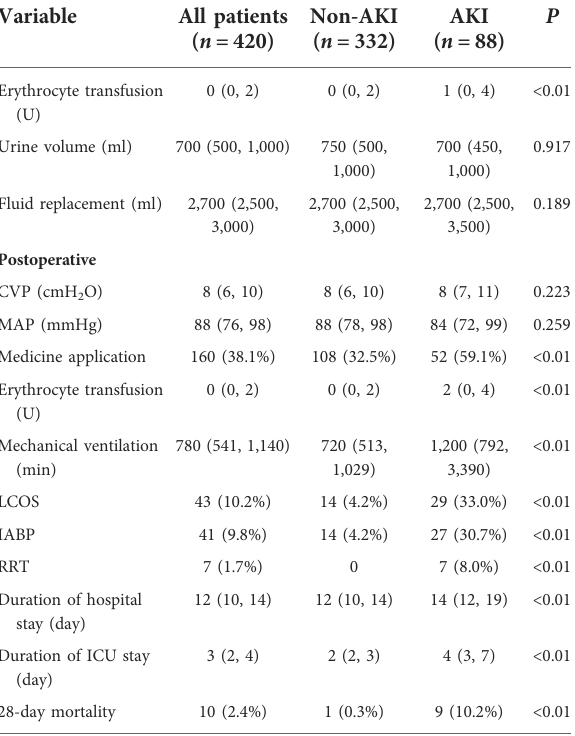
TABLE 2 Characteristics of the study